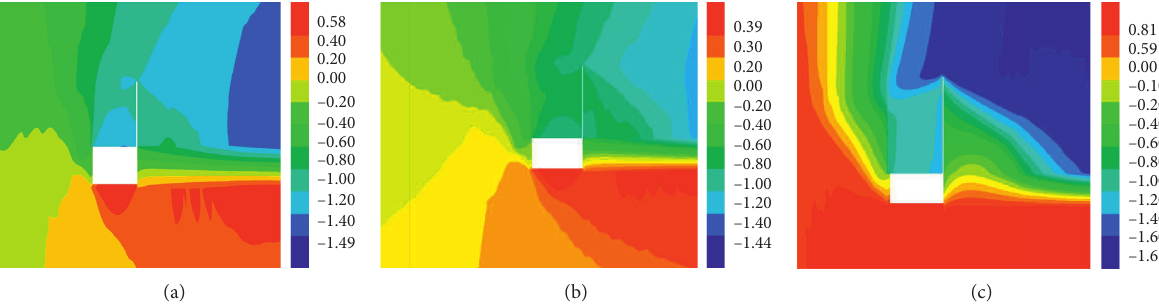
Figure 6: Vertical displacement distribution under different roof cutting heights m. (a) Roof cutting height of 6 m. (b) Roof cutting height of 8m. (c) Roof cutting height of